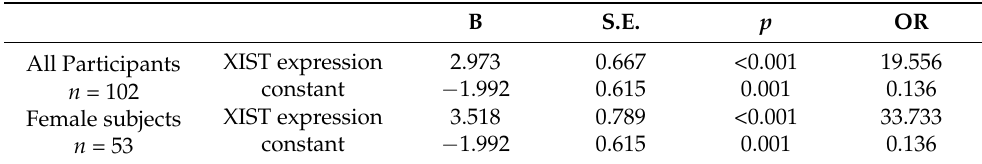
Table 5. Binomial logistic regression of OSCC.